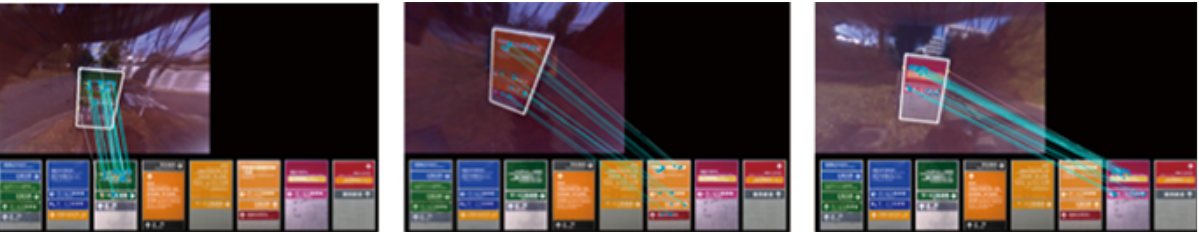
Figure 14 . Results after recognizing focused objects using SIFT. The corresponding points are indicated in light blue, and the white rectangle shows an area of the estimated object.